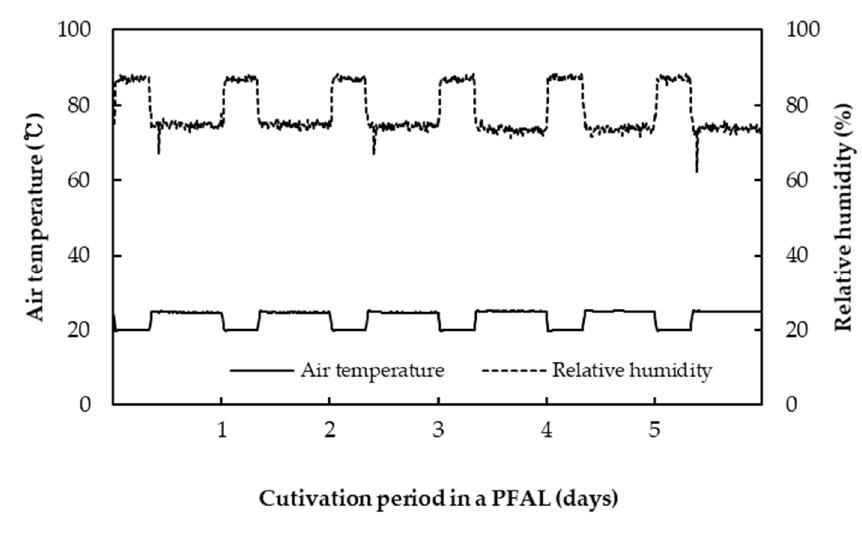
Figure 3. Air temperature and relative humidity conditions at 16 h · d − 1 in this experiment.